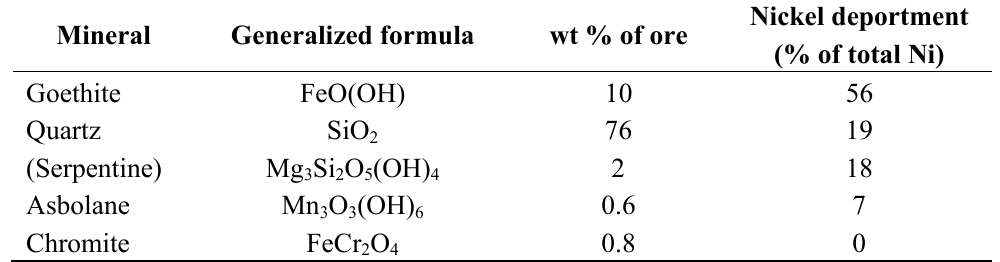
Nickel deportment (% of total Ni)